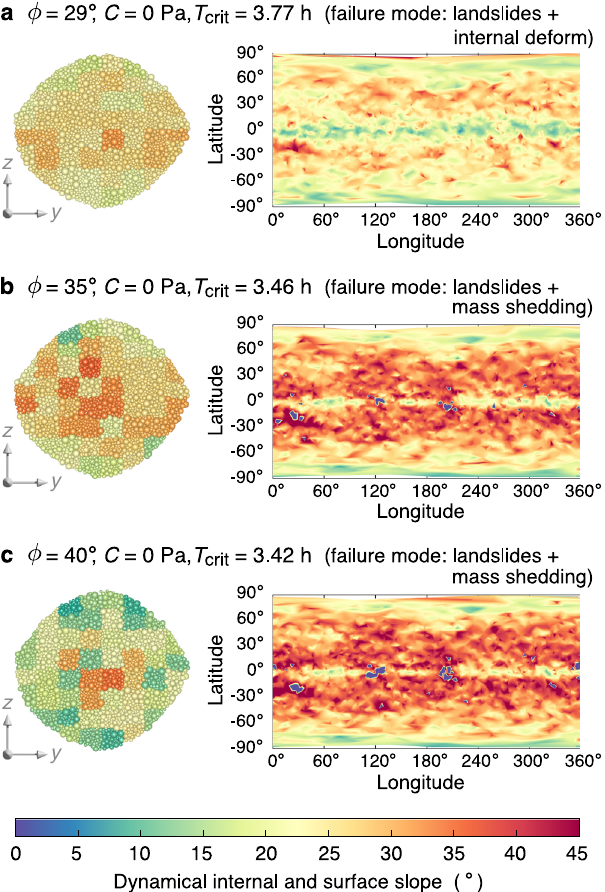
Fig. 2 | Pattern of internal and surface failure regions of cohesionless rubble piles. a – c Dynamical internal slopes over a cross-section and surface slope map at thecriticalspinperiod T crit forsimulationswiththreefrictionangles ϕ ,respectively. The surface regions where material can be lofted are marked with negative slopes (the bluish areas). Regional failure is initiated when the local dynamical internal/ surface slope exceeds the value of ϕ , which determines the failure behaviours as indicated on the top of each panel. The dynamical internal slope are calculated based on the averaged-stress analysis using representative volume elements (the patches shown represent the elements in these cross-sections), and the dynamical surface slope are derived based on the rubble-pile alpha-shape model (Methods). Source data are provided as a Source Data fi le.